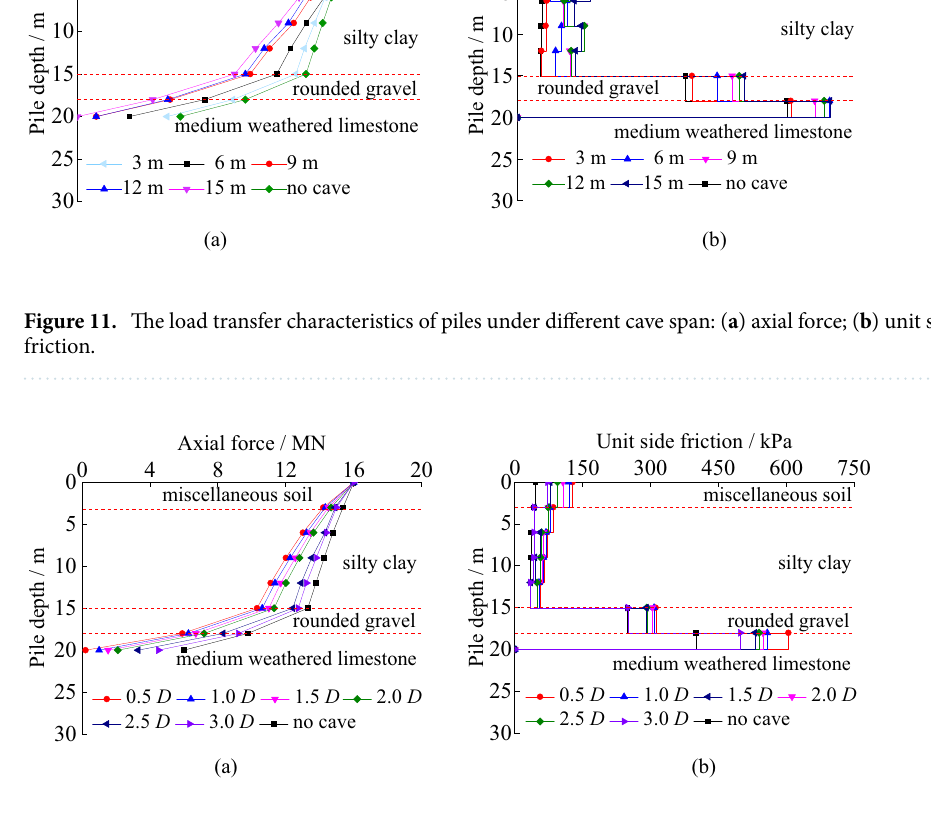
Figure 12. The load transfer characteristics of piles with different roof thickness: ( a ) axial force; ( b ) unit side